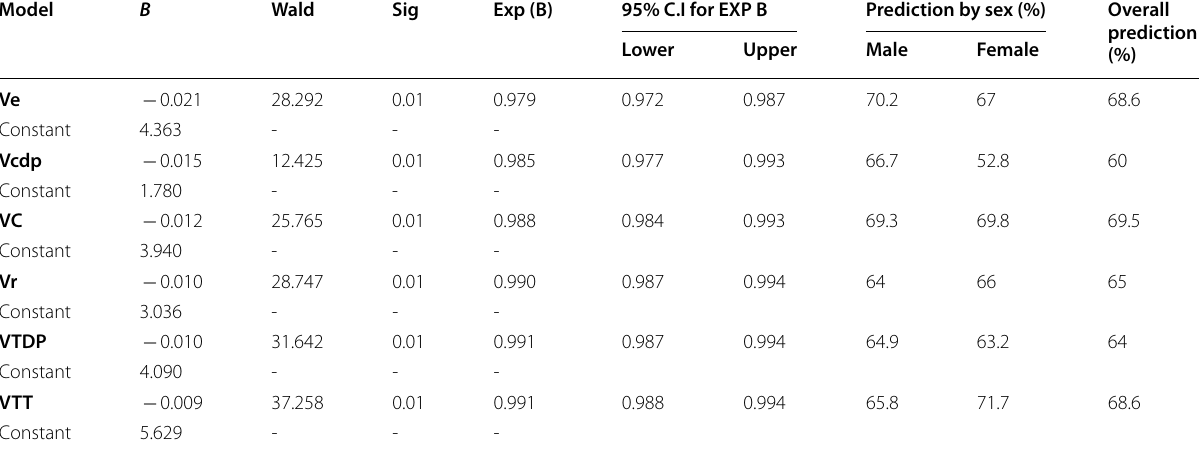
Note: The odd cut value is 0.5, considering above this value is female and below is male, B coefficient for the constant, Wald Wald chi-square value, Sig p value, Exp (B) exponentiation of the B coefficient, Ve volume of enamel, Vcdp volume of coronal dentine and pulp, VC total crown volume, Vr volume of root, VTDP total dentine and